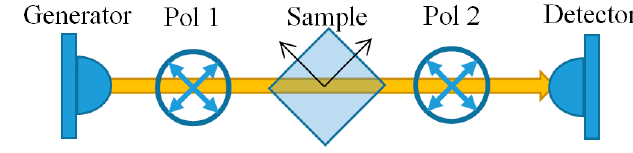
Figure 3. Schematic of the suggested measurement method.